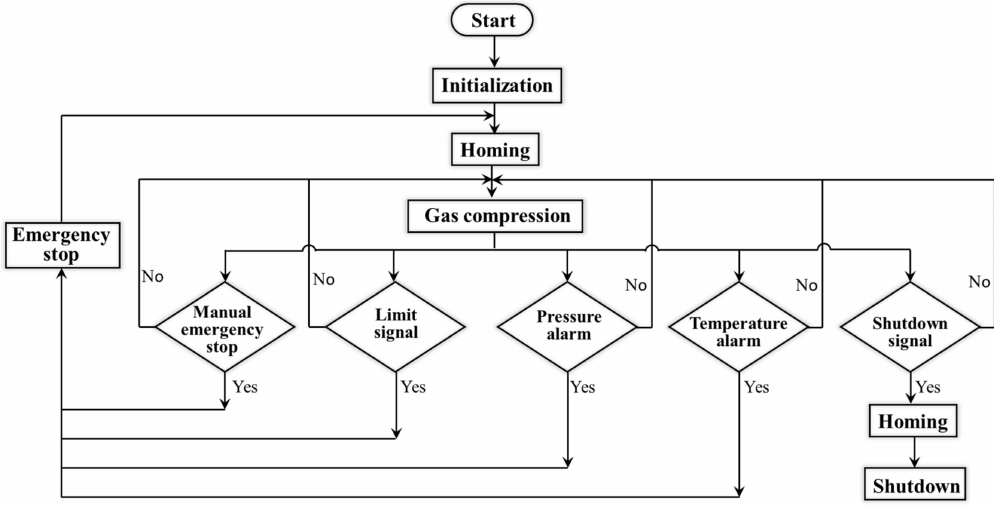
Figure 10. The flowchart of the motion control process.